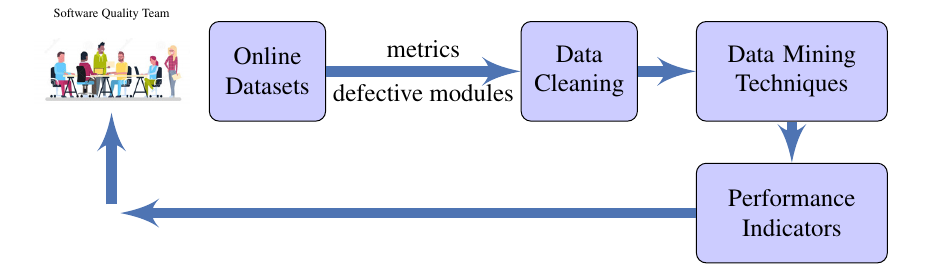
Table 1. Summary of the datasets employed